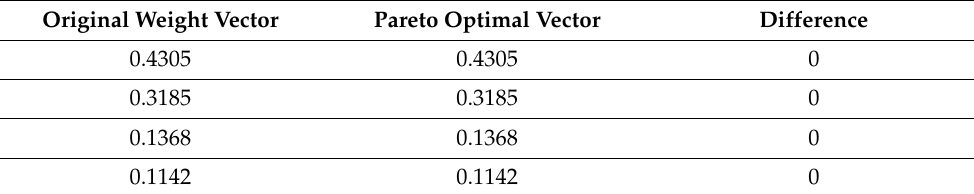
Table 7. The Pareto test on the four-dimensional weight vector of the decision